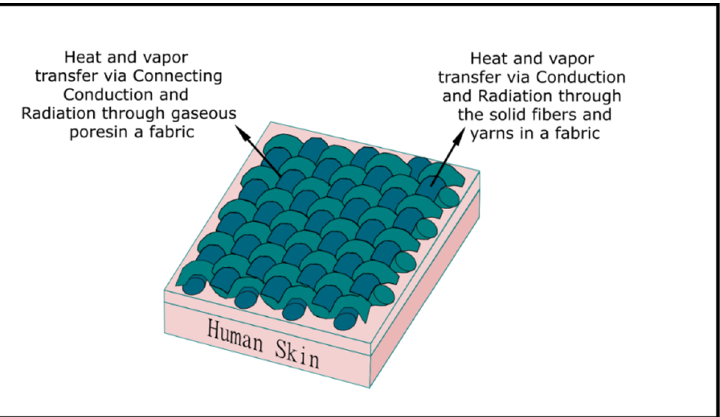
Figure 4. Heat and mass transfer through porous fabrics.